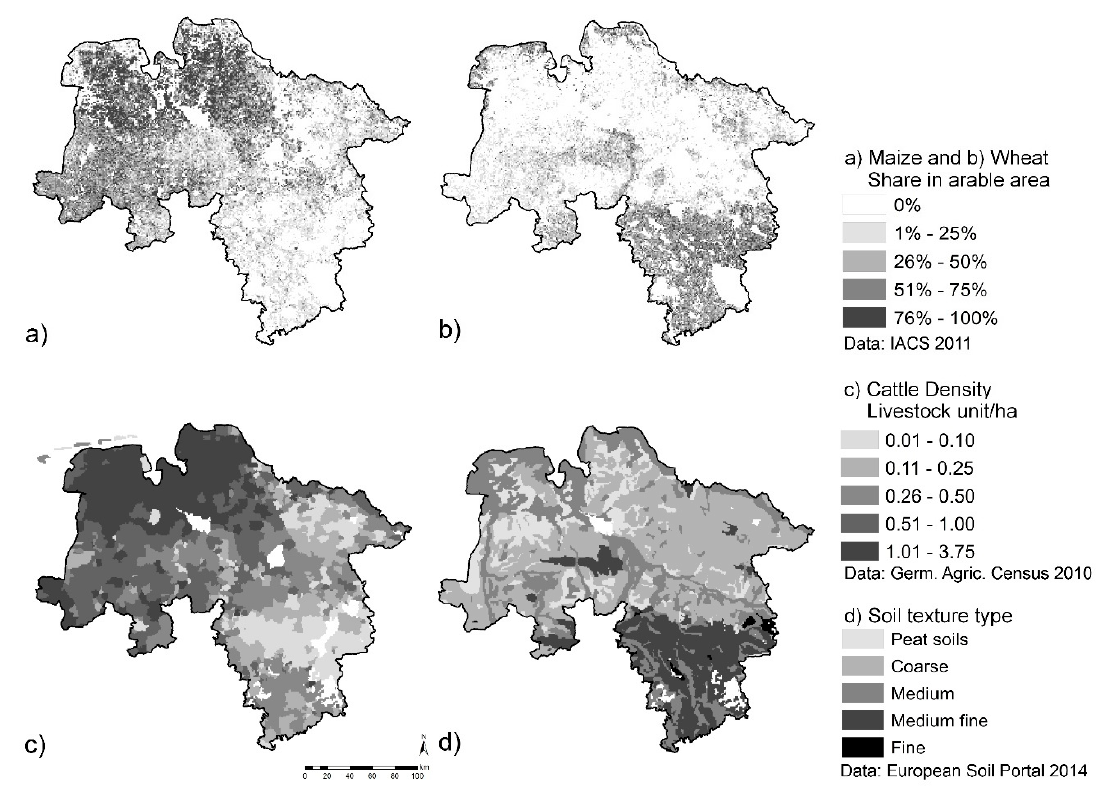
Figure 2. Exemplary mapping of the spatial distribution of two crops and two variables: ( a ) acreage of maize 2011; ( b ) acreage of winter wheat 2011; ( c ) cattle density per LAU-2 unit; ( d ) soil texture distribution.